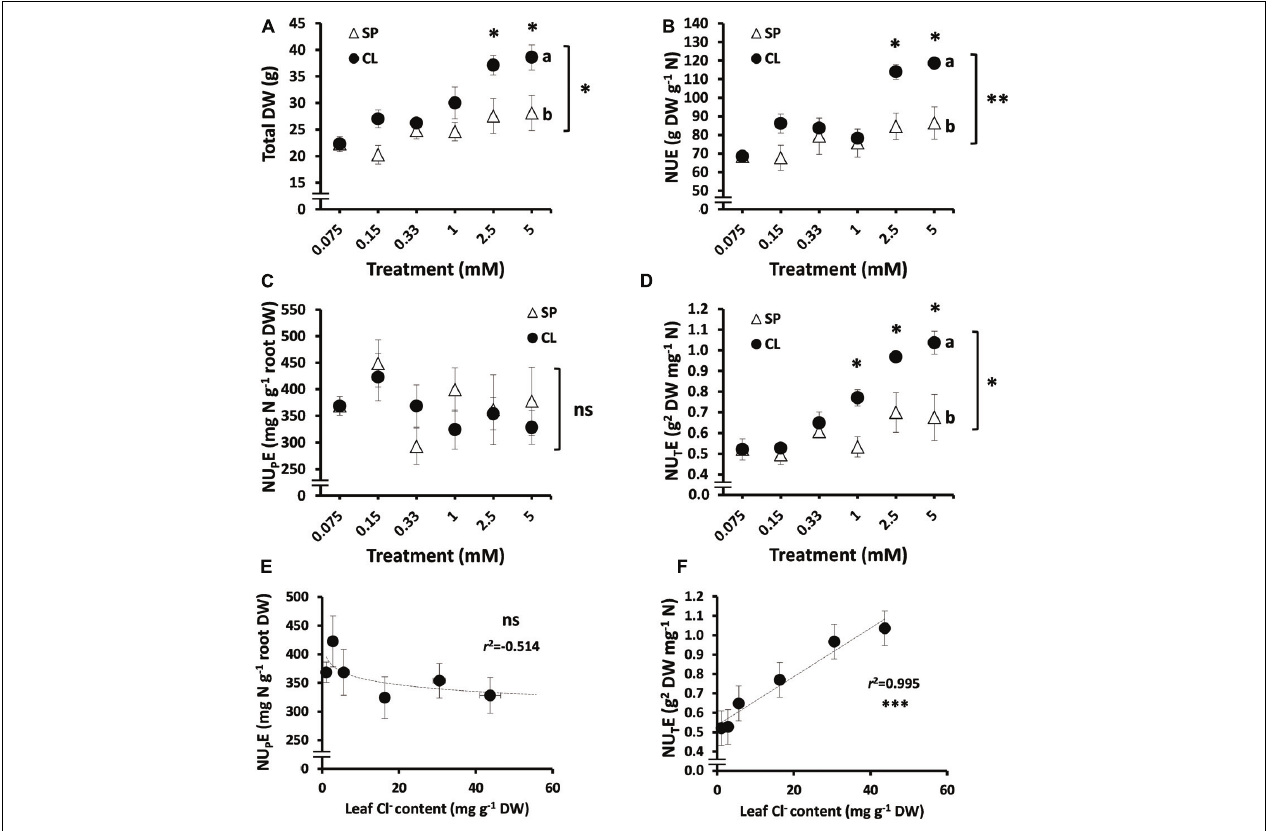
FIGURE 2 | Effect of Cl − nutrition on tobacco plant biomass and nitrogen use efficiency (NUE) parameters. Treatments consisted of increasing concentrations of Cl − (CL) or SO 42 − + PO 43 − (SP) salts maintaining the same cationic balance. (A) Effect on total dry weight (DW). (B) NUE. (C) Nitrogen-uptake efficiency (NU P E). (D) Nitrogen-utilization efficiency (NU T E); (E) Pearson correlation ( r 2 ) between NU P E and leaf anion content in tobacco plants. (F) Pearson correlation ( r 2 ) between NU T E and leaf anion content in tobacco plants. Mean values ± SE, n = 4–6. Levels of significance: P > 0.05 (ns, not significant), ∗ P ≤ 0.05, ∗∗ P ≤ 0.01, and ∗∗∗ P ≤ 0.001; and “homogeneous group” statistics was calculated through ANOVA and multivariate (MANOVA) tests, where mean values with different letters are significantly different according toTukey’s test. Correlations between NU T E or NU P E and leaf anion content were calculated through the Pearson’s product-moment correlation coefficient ( r 2